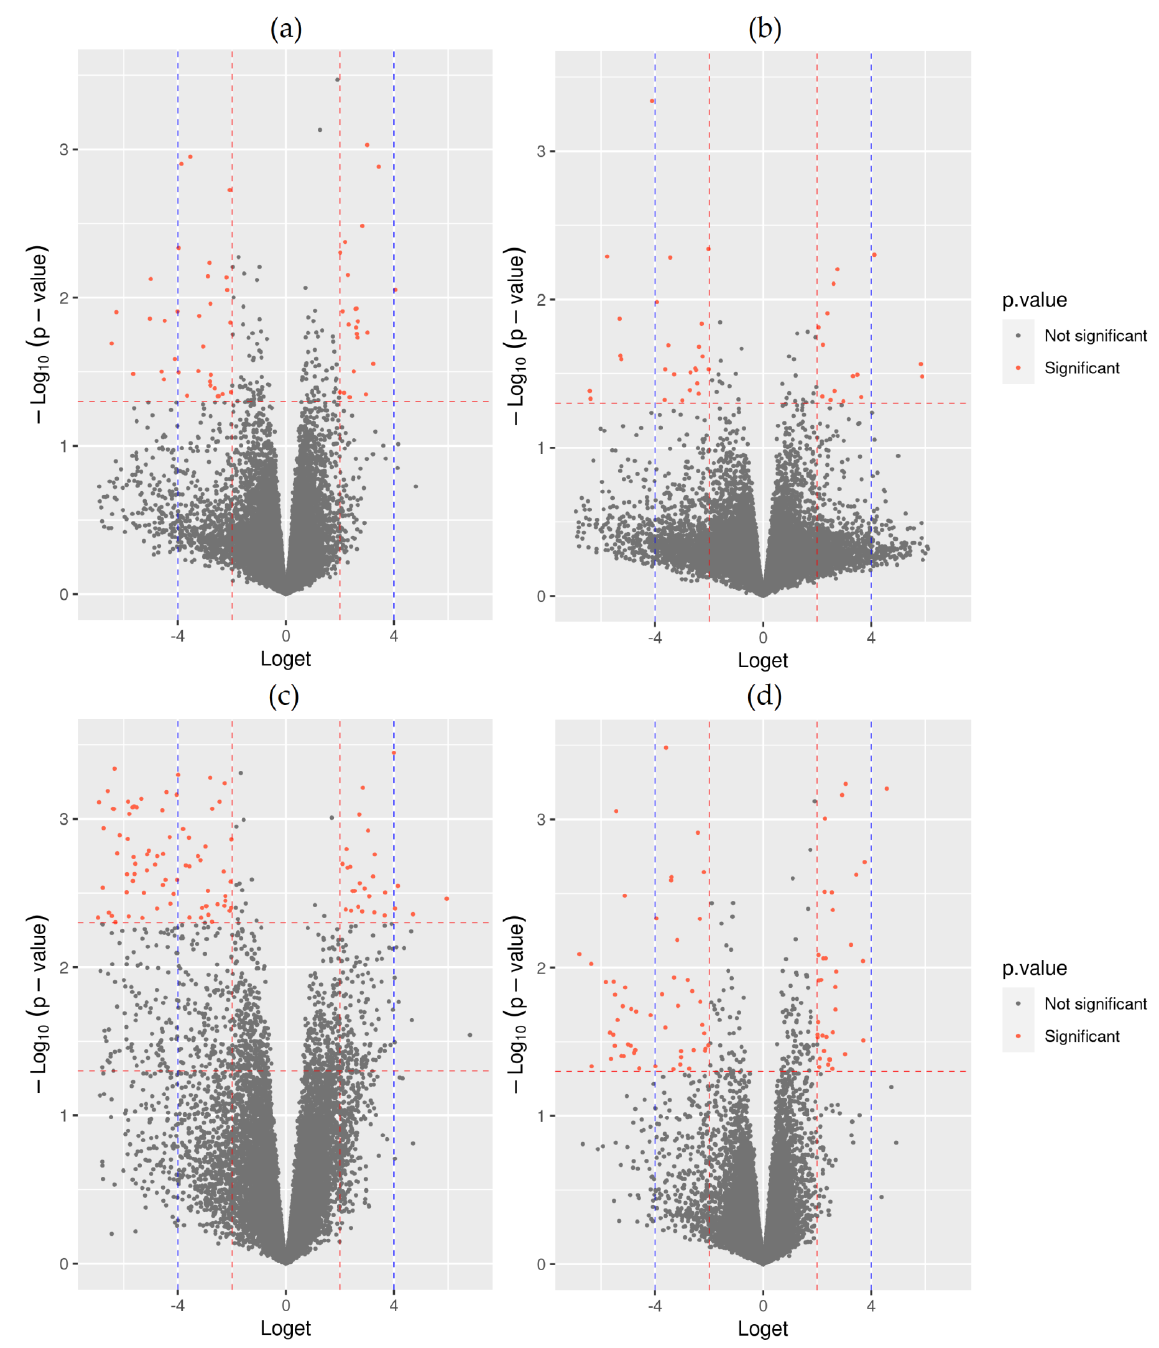
Figure 1. Volcano plots of RNA-seq transcript specific analyses. ( a ) First approach; ( b ) approach corrected for T cells deconvolution fraction; ( c ) approach corrected for monocytes/macrophages deconvolution fraction; ( d ) approach corrected for dendritic cells deconvolution fraction. Red dashed lines indicate borders for statistically significant differentially expressed transcripts.